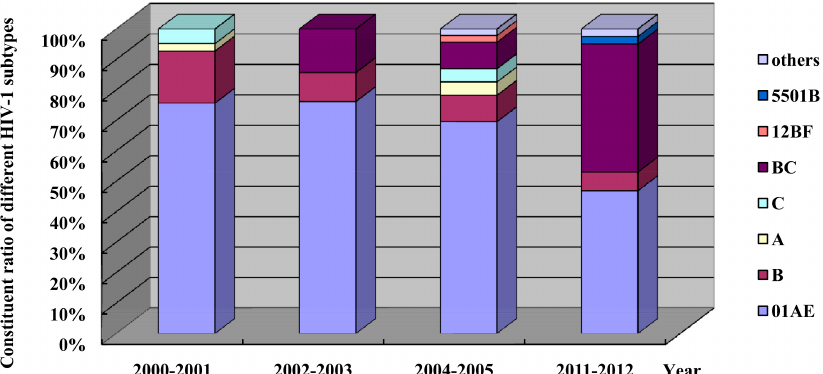
Figure 10. Distribution and shift of HIV-1 subtypes in Fujian Province, revealed by four molecular epidemiological surveys of HIV.